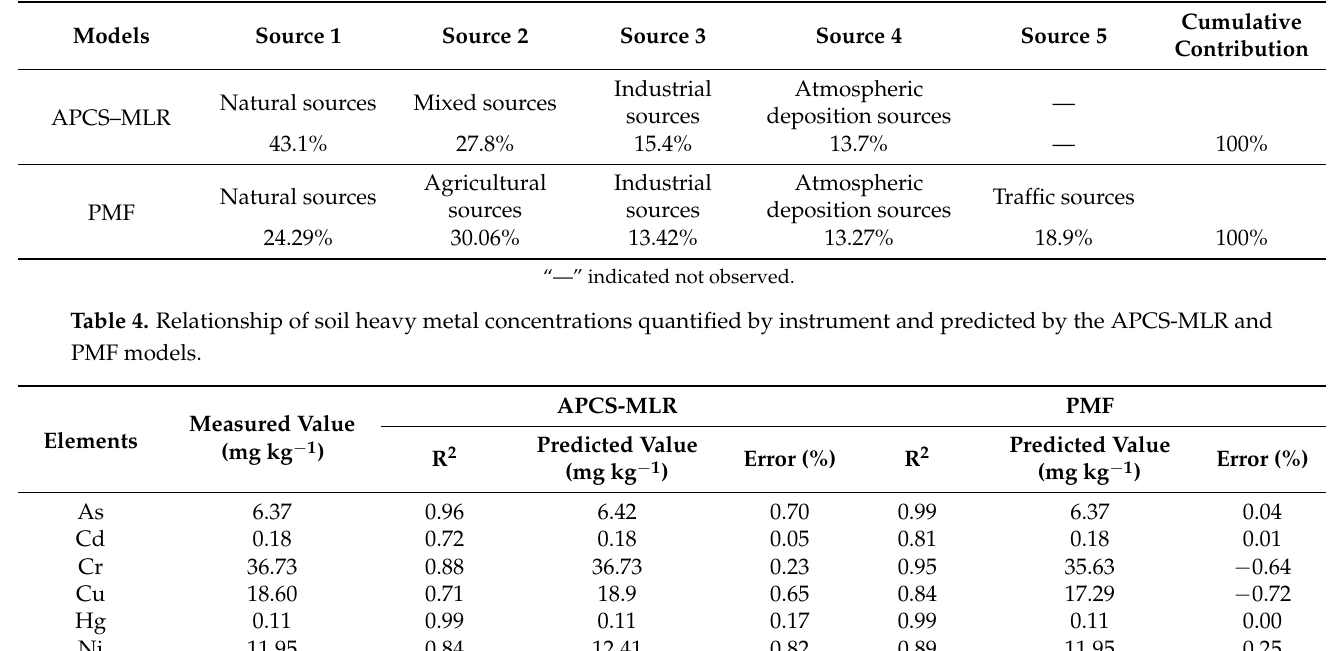
Table 3. Comparison results of APCS-MLR and PMF sources analysis.